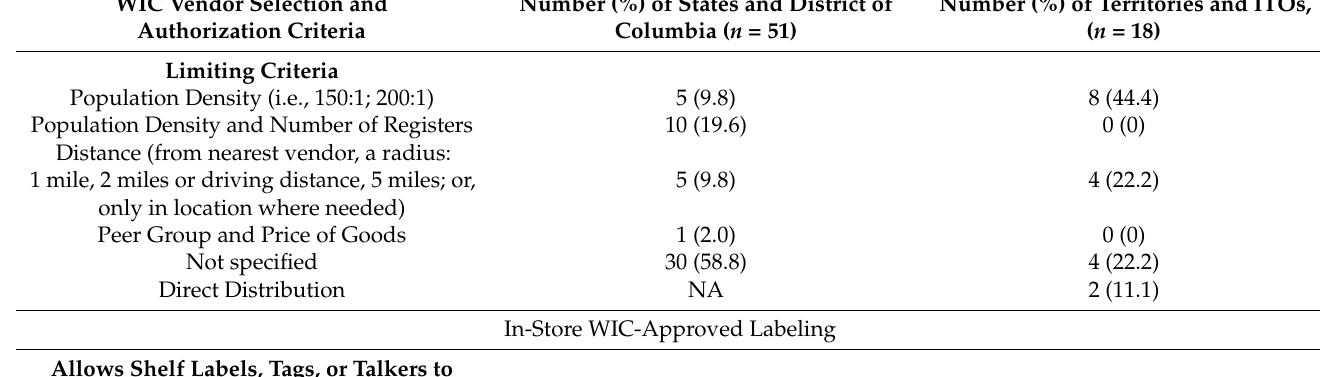
Table 3. Vendor Management and Operations Criteria for Administrative Agency-Authorized WIC Retailers, 2018–2020. WIC Vendor Selection